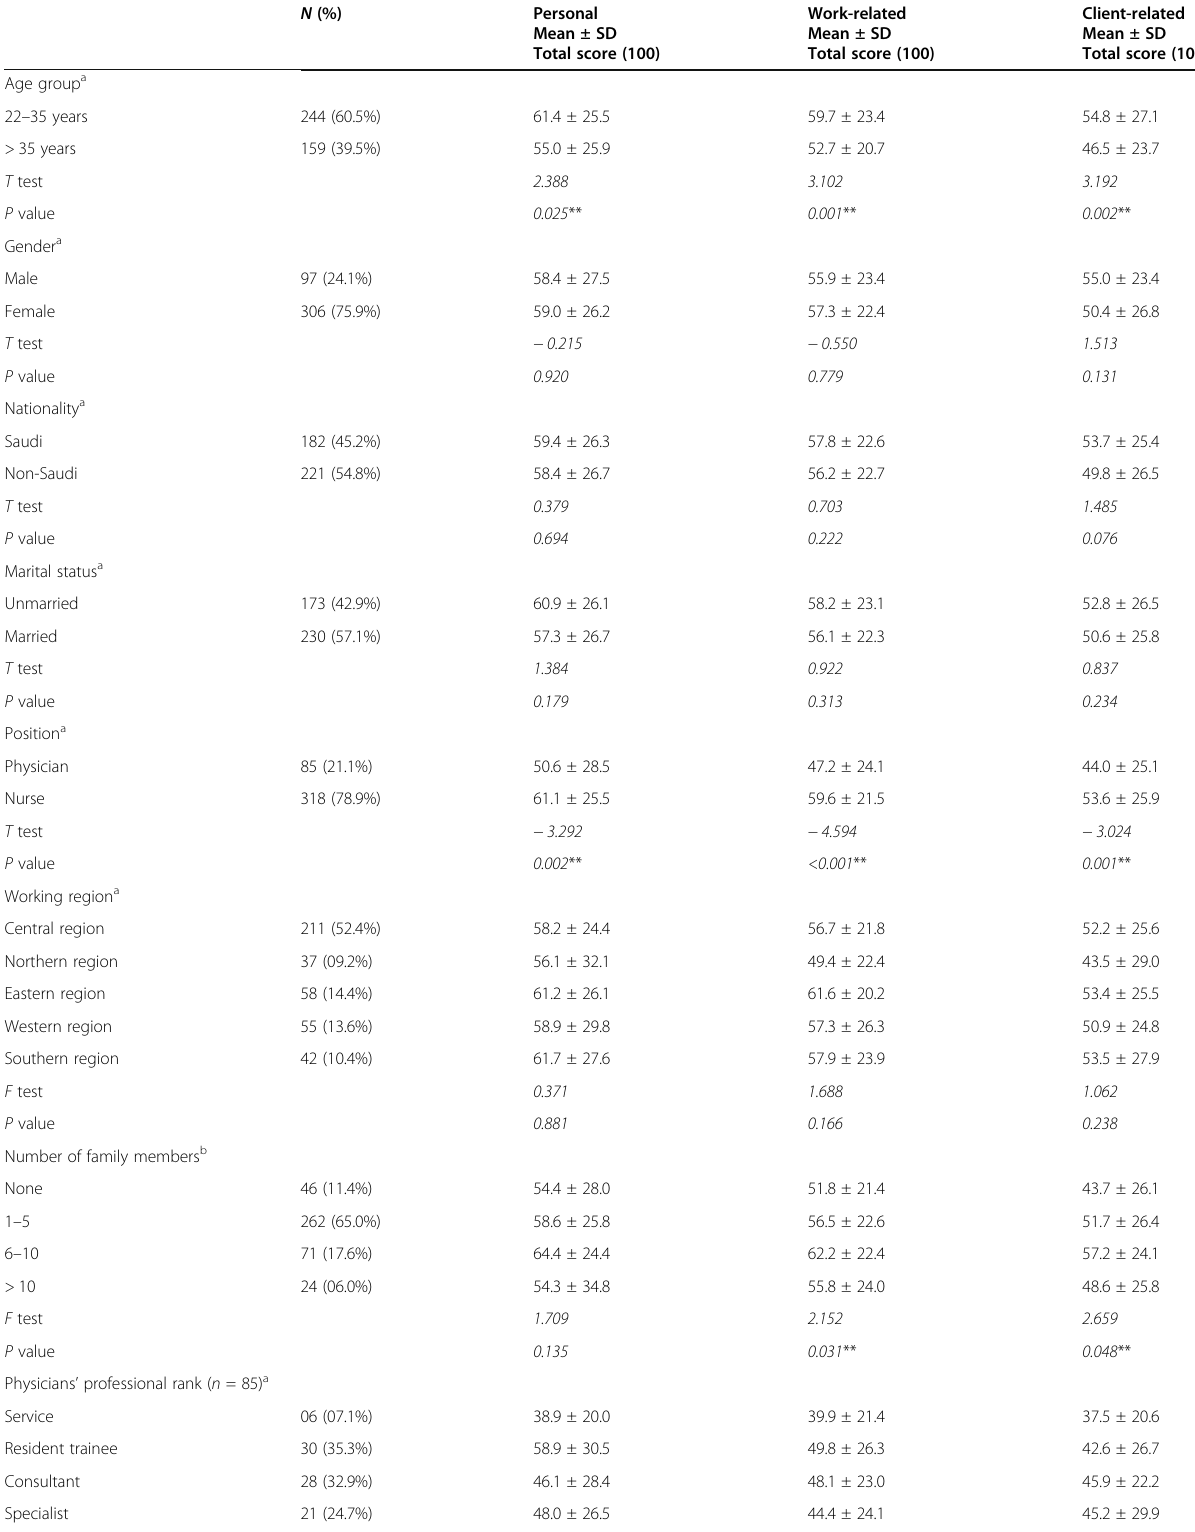
Table 3 Respondents ’ sociodemographic characteristics ( n = 403) and statistical associations between the CBI